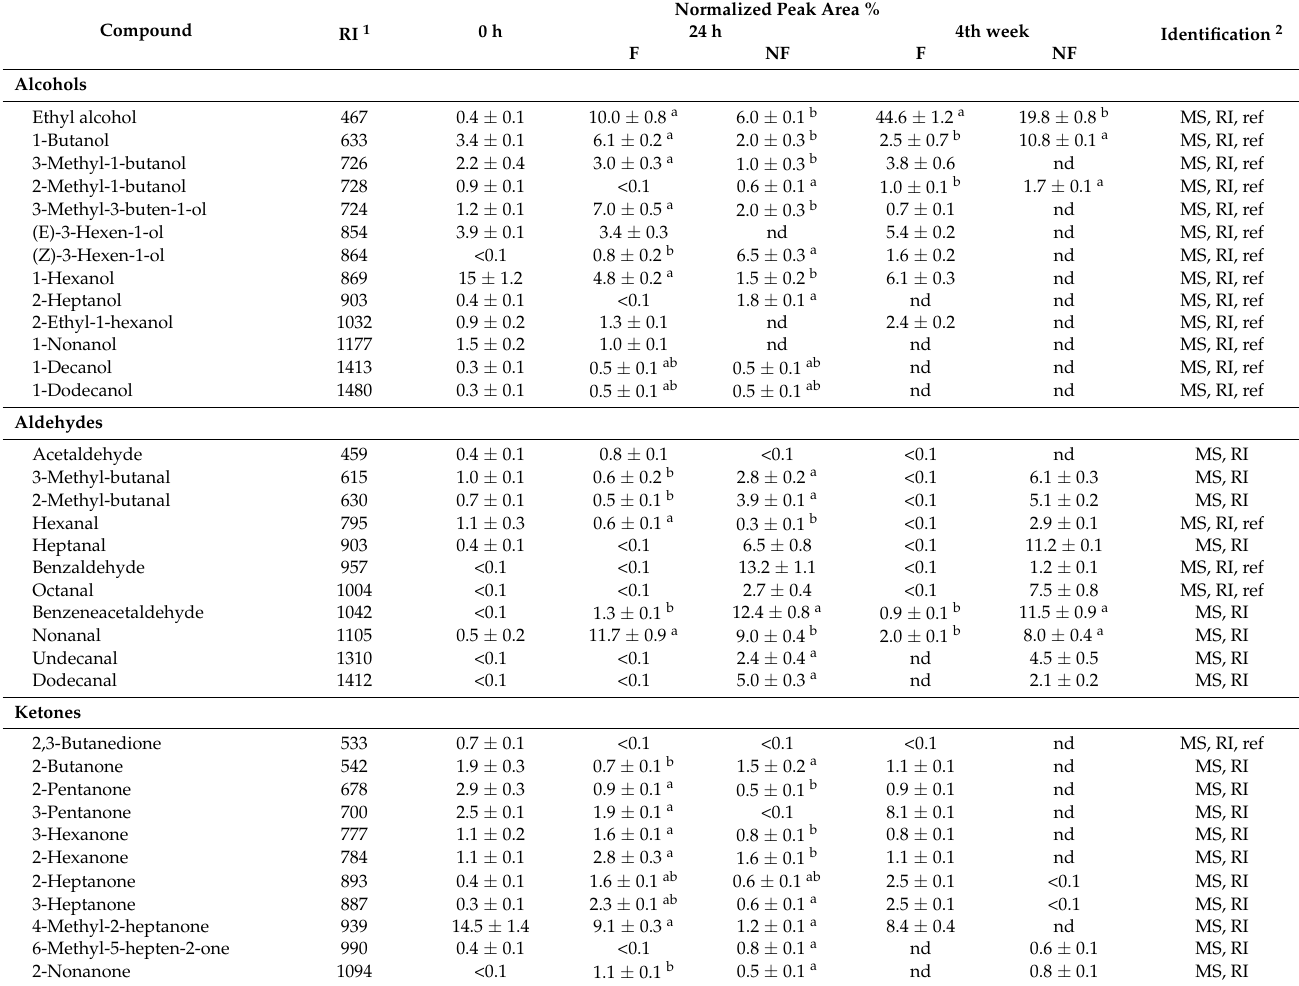
Table 3. Volatile compounds identified in the non-fermented (NF) and fermented pomegranate juice (F) by Lactobacillus plantarum ATCC 14917 at 0 h and 24 h of fermentation as well at the 4th week of